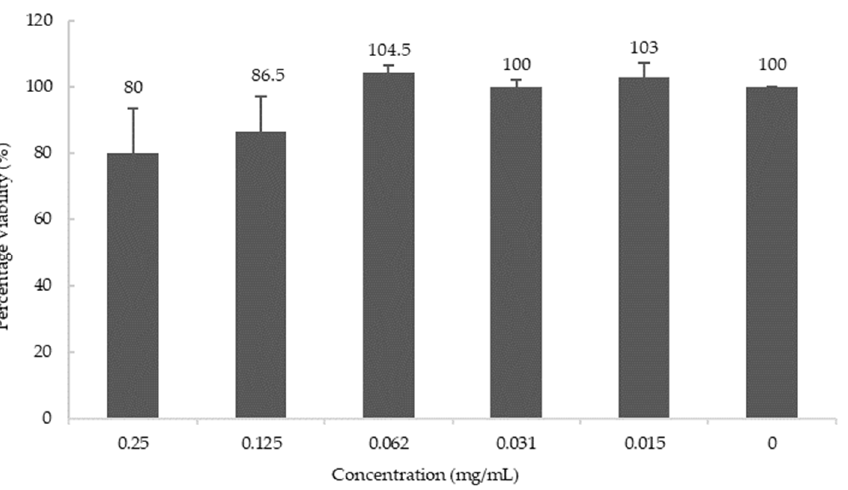
Figure 4. Cell Viability at various concentrations of blueberry extract. Values are presented as the mean ± SD of n = 6.